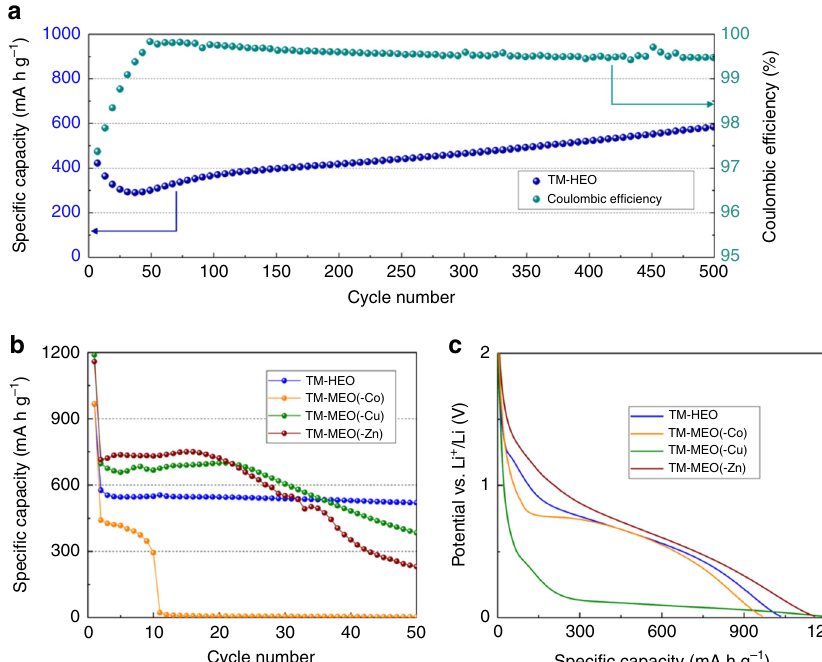
Fig. 2 Speci fi c capacities and lithiation pro fi les of TM-HEO and TM-MEO. Comparison of the different medium and high entropy oxides under investigation. a Long-term cycling stability of the calcined TM-HEO at 200 mA g ‒ 1 together with the corresponding Coulombic ef fi ciency. b It can be seen that the TM- HEO shows stable capacity retention at 50 mA g ‒ 1 , while the materials without Zn and Cu reveal severe capacity degradation. The material without Co fails completely after 10 cycles. c Discharge (lithiation) pro fi les of the fi rst cycle for the different compounds. The material without Cu shows a signi fi cantly lower discharge potential and it might be interesting as anode material for primary batteries